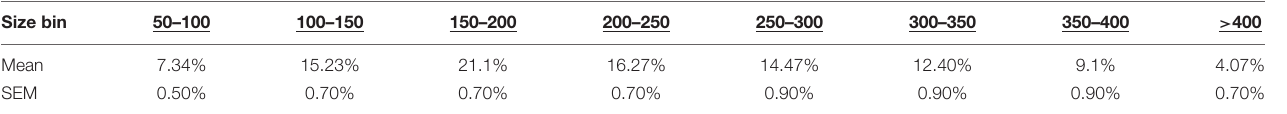
TABLE 2 | Tissue volume percentages from 184 human islet preparations broken into IEQ counting size